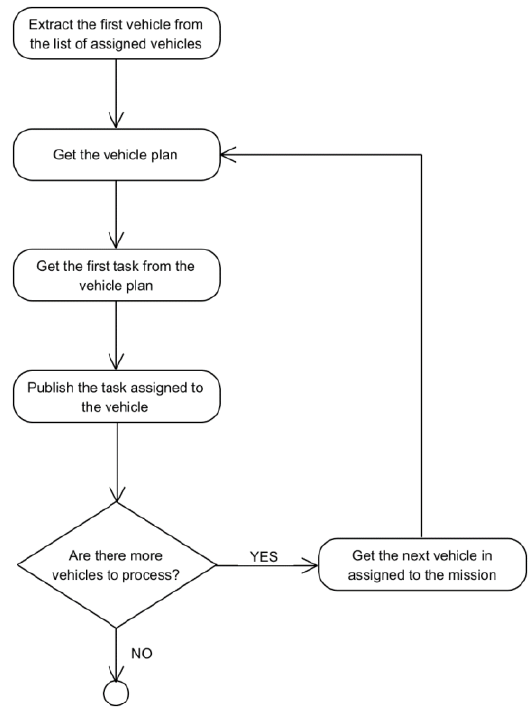
Figure 12. Flow diagram for the task assignment when done by wait for completion.